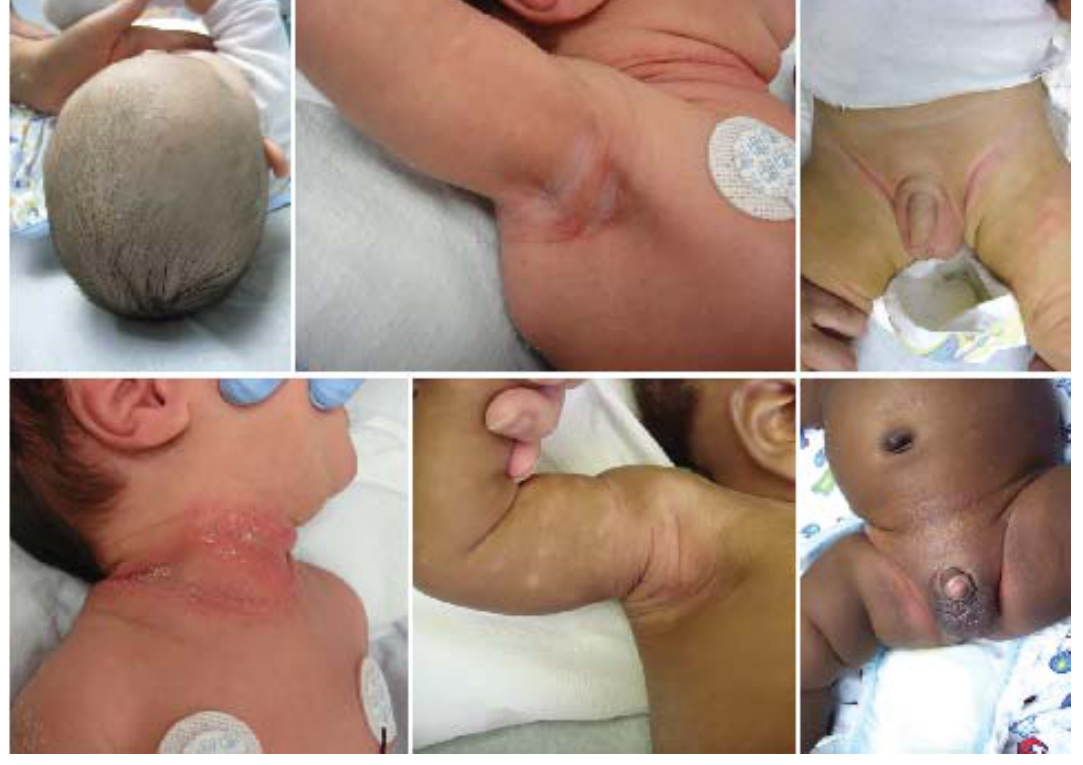
Figure 2. Seborrheic